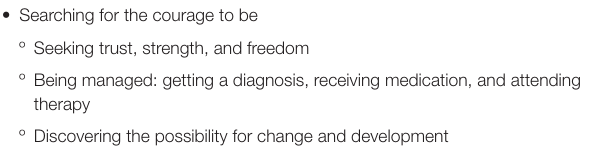
TABLE 1 | Overview of the main themes and